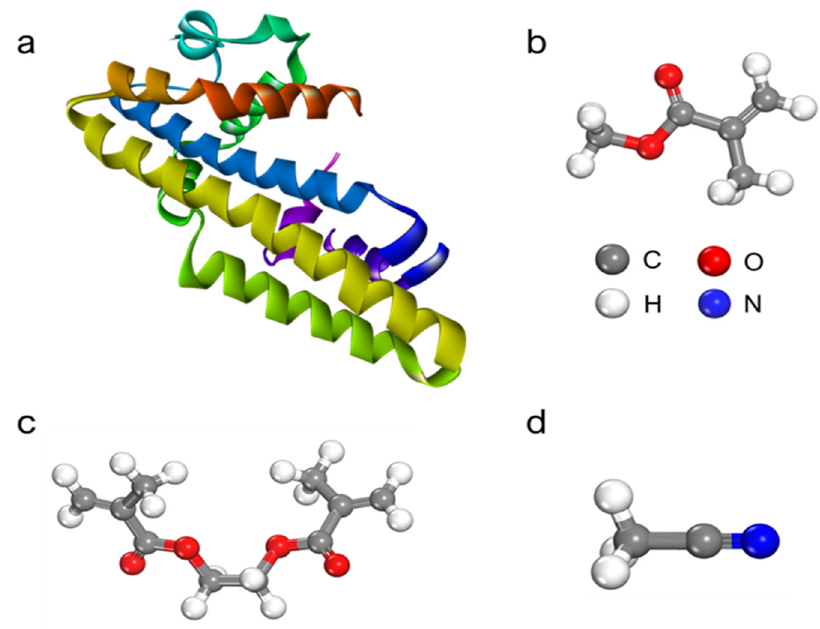
Figure 1. Chemical structures of MIP optimization components including ( a ) CagA, ( b ) MMA, ( c ) EGDMA, and ( d ) ACN. CagA was represented in the ribbon diagram, while other molecules were displayed in the ball and stick